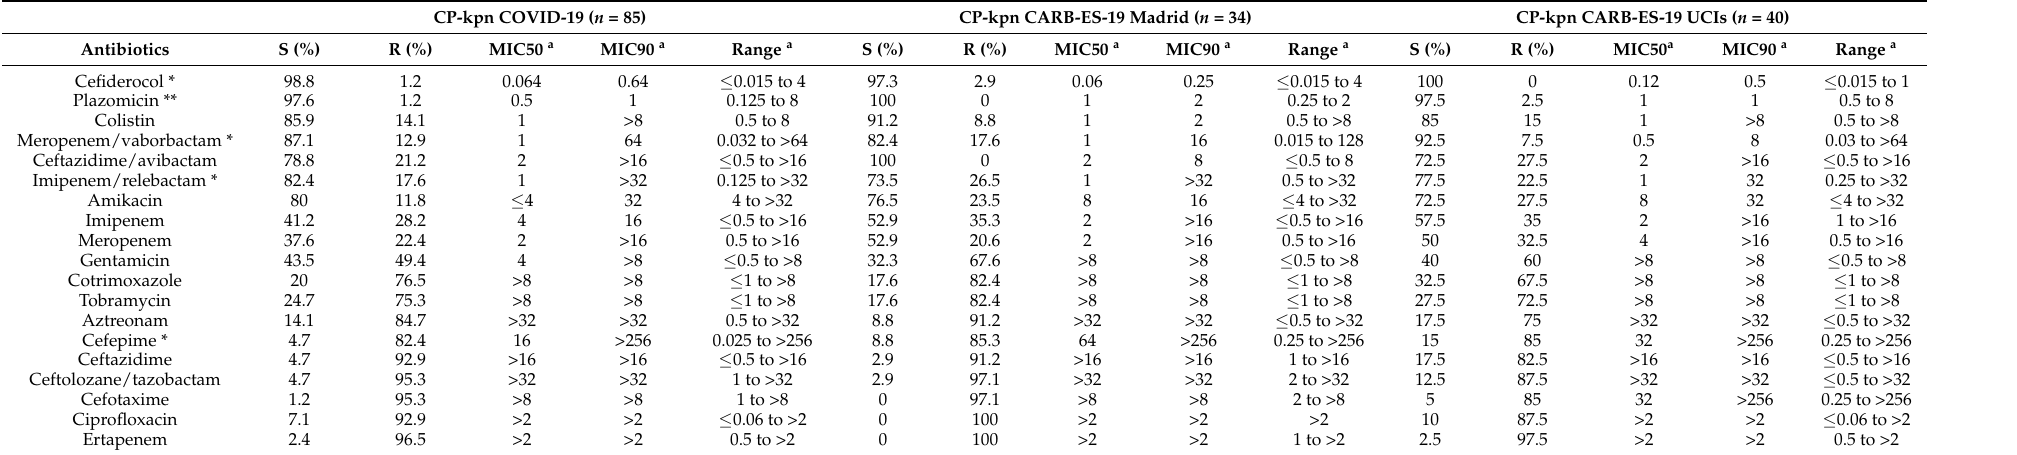
Table 1. Antibiotic susceptibility of different groups of carbapenemase-producing Klebsiella pneumoniae isolates as determined by the microdilution method and antibiotic gradient strips according to EUCAST (*) and FDA (**) clinical breakpoints, respectively. CP-kpn COVID-19 ( n = 85) CP-kpn CARB-ES-19 Madrid ( n = 34) CP-kpn CARB-ES-19 UCIs ( n =